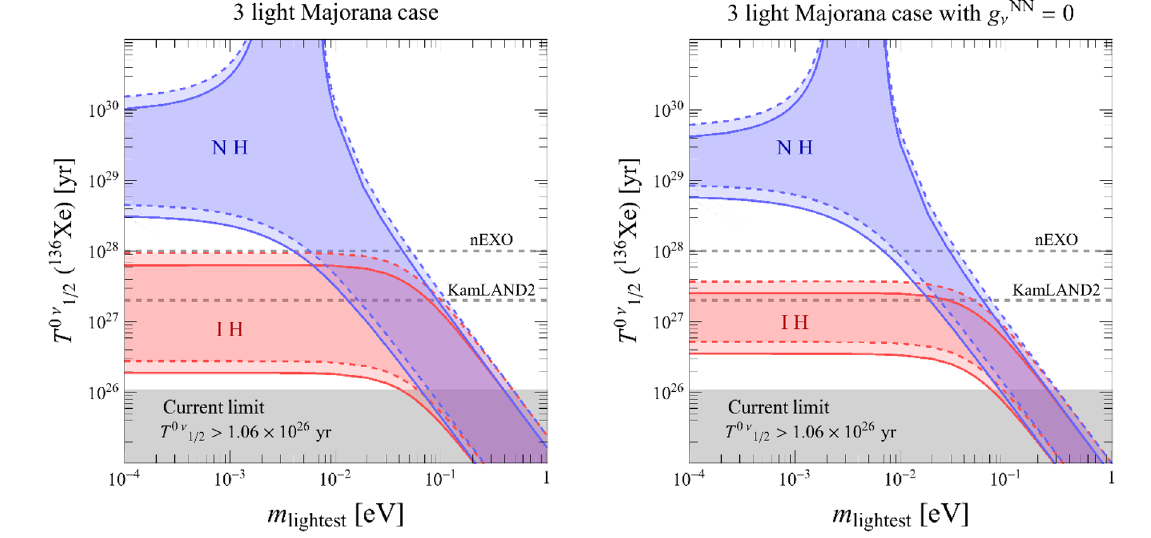
Figure 6 . 0 (cid:23)(cid:12)(cid:12) half-life of 136 Xe as a function of the lightest neutrino mass in the scenario of 3 light Majorana neutrinos in case of the normal hierarchy (blue) and inverted hierarchy (red). We show results obtained with QRPA (solid) or the Shell Model (dashed) NMEs. In the left panel, the bands re(cid:13)ect the uncertainty due to LECs associated to hard-neutrino exchange and the unknown Majorana phases. In the right panel, we ignore the contributions from hard-neutrino exchange as typically done in the literature and the bands arise solely from varying the unknown Majorana phases. The shaded regions in both panels correspond to the present experimental limit, and expected future limits are depicted by the two dashed